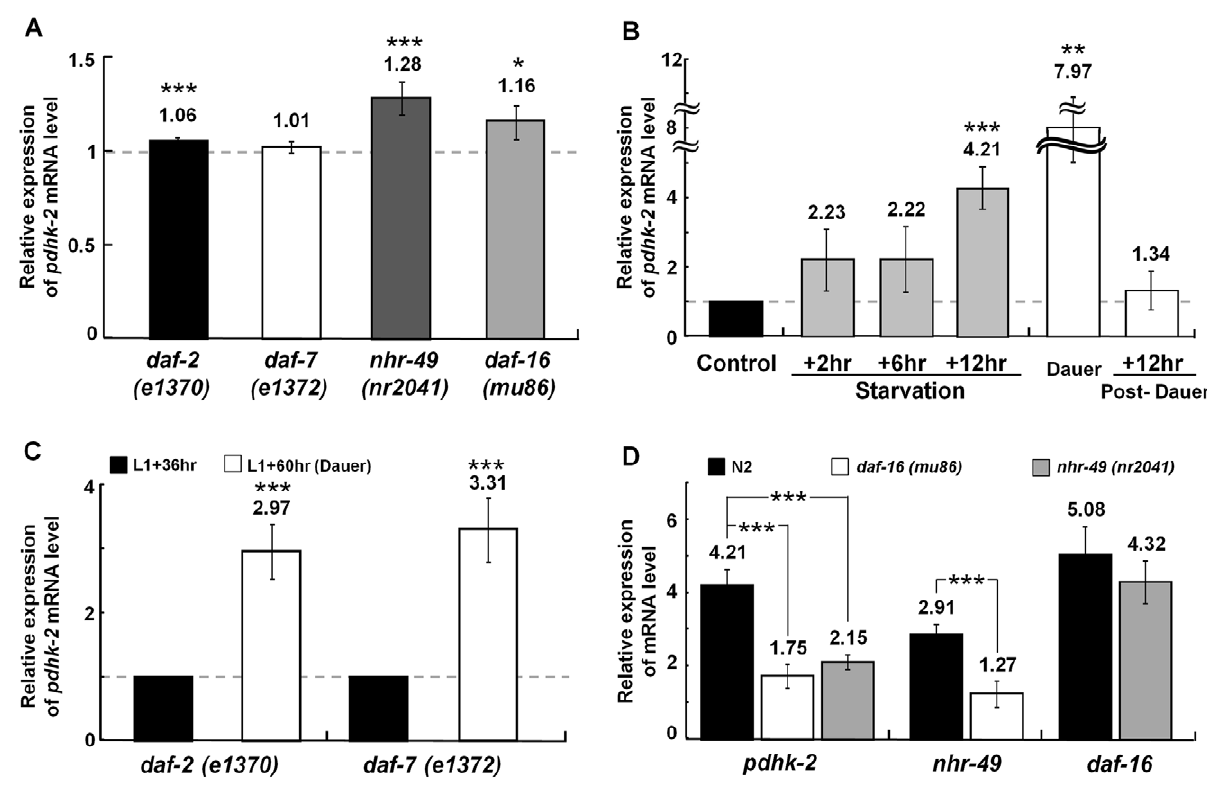
Figure 1. pdhk-2 mRNA levels under various conditions. Changes in pdhk-2 gene expression were determined by real-time qPCR. ( A ) Expression levels of pdhk-2 in daf-2(e1370) , daf-7(e1372) , nhr-49(nr2041) , and daf-16(mu86) mutants from well-fed L4 stage worms. The data were normalized to N2 well-fed L4-stage worms. ( B ) Expression levels of pdhk-2 in N2 worms starved for 2, 6 and 12 hours from the L4 stage, and in dauer and post-dauer stage worms. Dauer worms were obtained after starving for 7 days at 20 u C, whereas post-dauer worms were produced by feeding dauer worms for 12-hour at 20 u C. The values were normalized to well-fed conditions at the L4 stage worms. Worms maintained under well-fed conditions at the L3 stage were used as controls for the dauer stage group. ( C ) Expression levels of pdhk-2 in daf-2(e1370) and daf-7(e1372) mutants in the pre-dauer (L1 + 36 hours) and dauer (L1 + 60 hours) states at 25 u C. The values were normalized to pre-dauer (L1 + 36 hours) worms. ( D ) Expression levels of pdhk-2 , nhr-49 and daf-16 in N2, daf-16(mu86) and nhr-49(nr2041) worms under 12-hour starvation conditions. In each experiment, mutant worms maintained under well-fed conditions at the L4 stage were used as controls for the starvation group. The values represent means [ 6 SDs] from three independent experiments. * p , 0.05, ** p , 0.01 and *** p , 0.001 compared with the control.